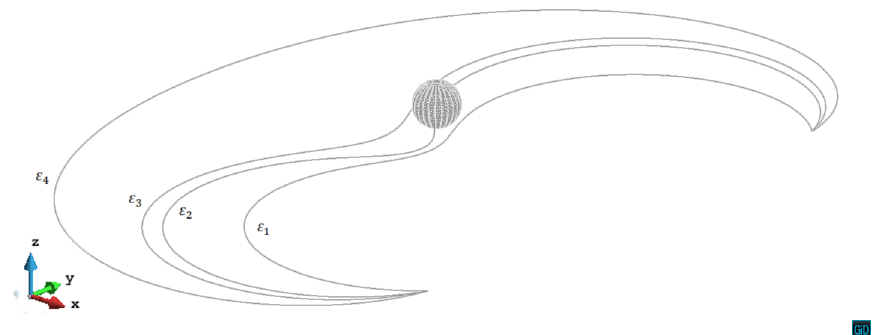
Figure 16. The gradual unpinning process of the dislocation line on the z / R = − 2.2 plane. The plastic strain of different steps ε 1 = 9.30 × 10 − 5 , ε 2 = 1.28 × 10 − 4 , ε 3 = 1.43 × 10 − 4 , ε 4 = 2.24 × 10 − 4